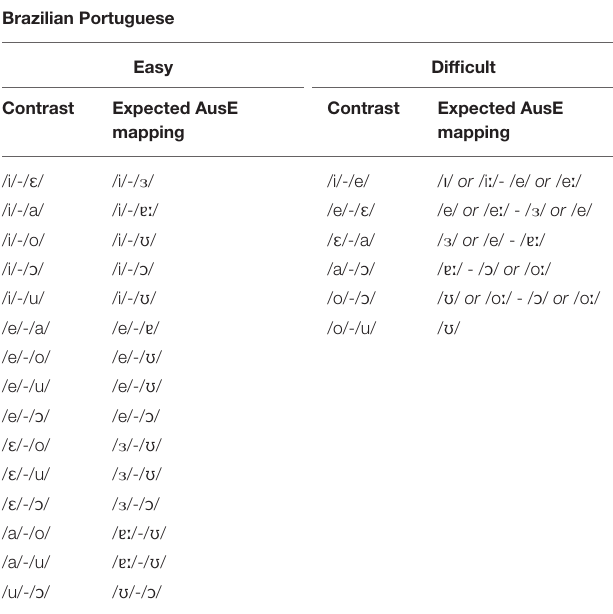
TABLE 3 | Easy and difficult vowel mappings of Brazilian Portuguese vowels to AusE